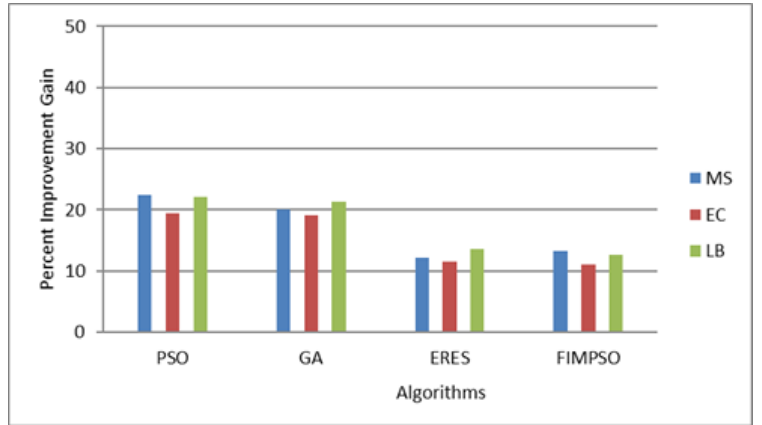
Figure 3. Percent improvement gain of the proposed algorithm over the other methods on the Sipht dataset.